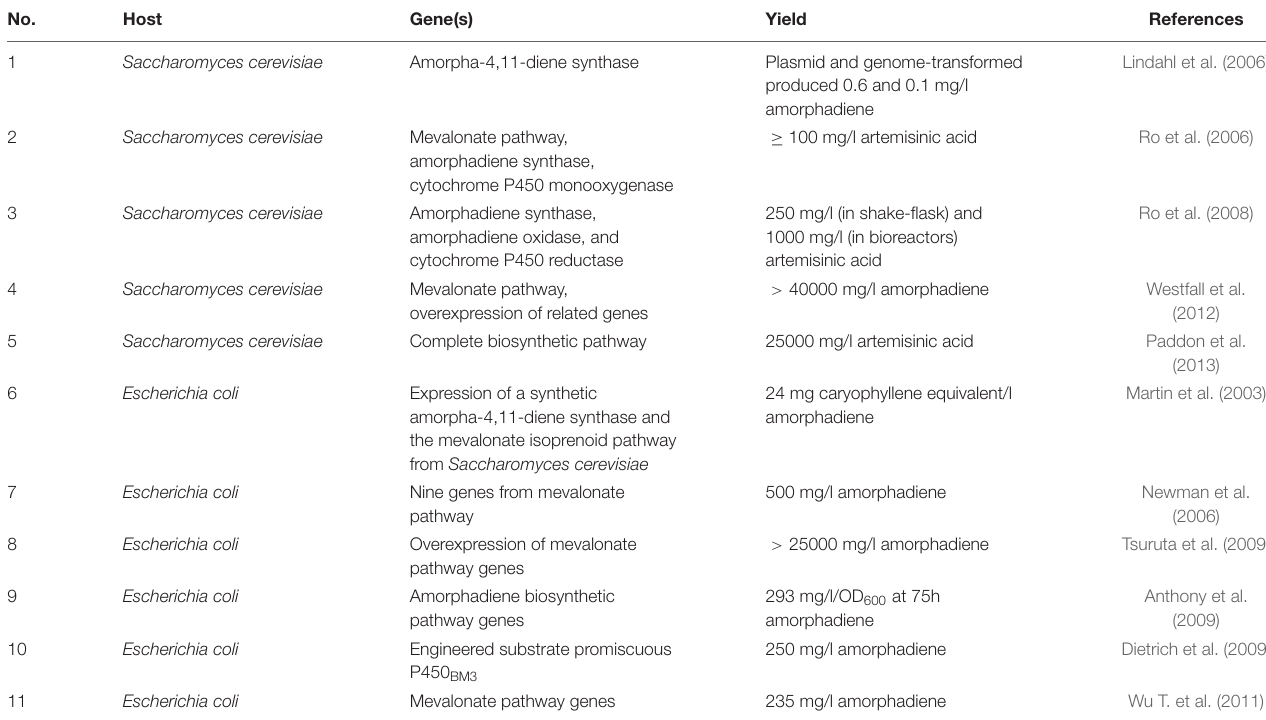
TABLE 4 | De novo production of ART precursor via synthetic biology.